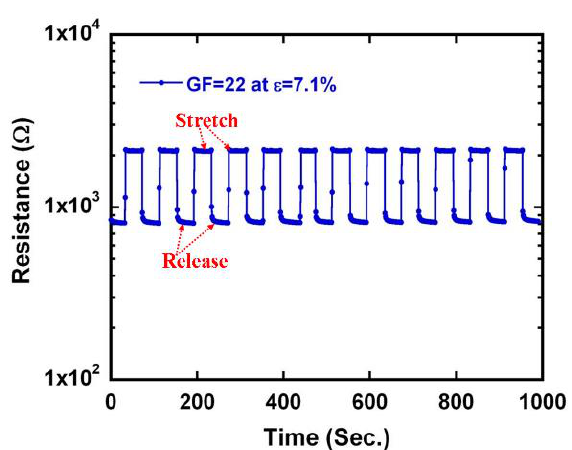
Figure 8. Many cycles of repeatedly stretching and releasing the LRS of the NT resistive memory under applied a fixed ε = 7.1%. The GF value of the LRS can be determined to be approximately 22 at the fixed ε = 7.1%.